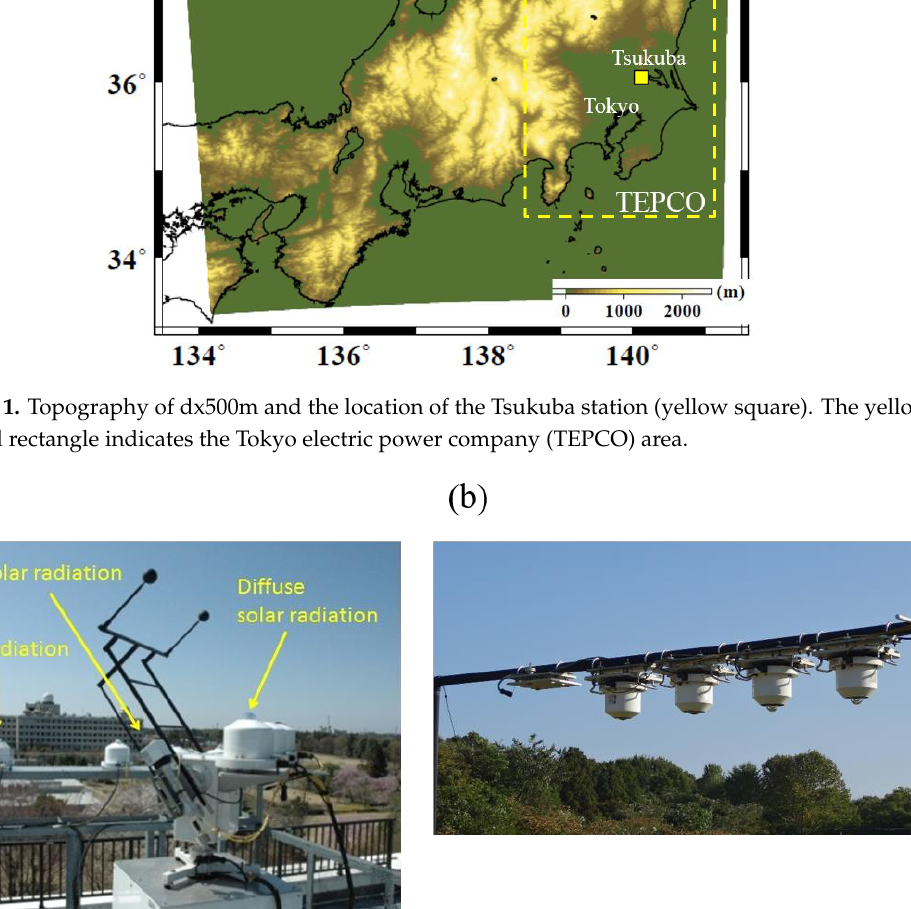
Figure 2. Photos of ( a ) BSRN instruments (GHI, DNI, and DIF, Source from the web site of JMA aerological observatory http://www.jma-net.go.jp/kousou/obs_third_div/rad/rad_sol.html) and ( b ) measurements of upward longwave radiation (ULW) instruments at Japan Meteorological Agency’s (JMA) aerological observatory.